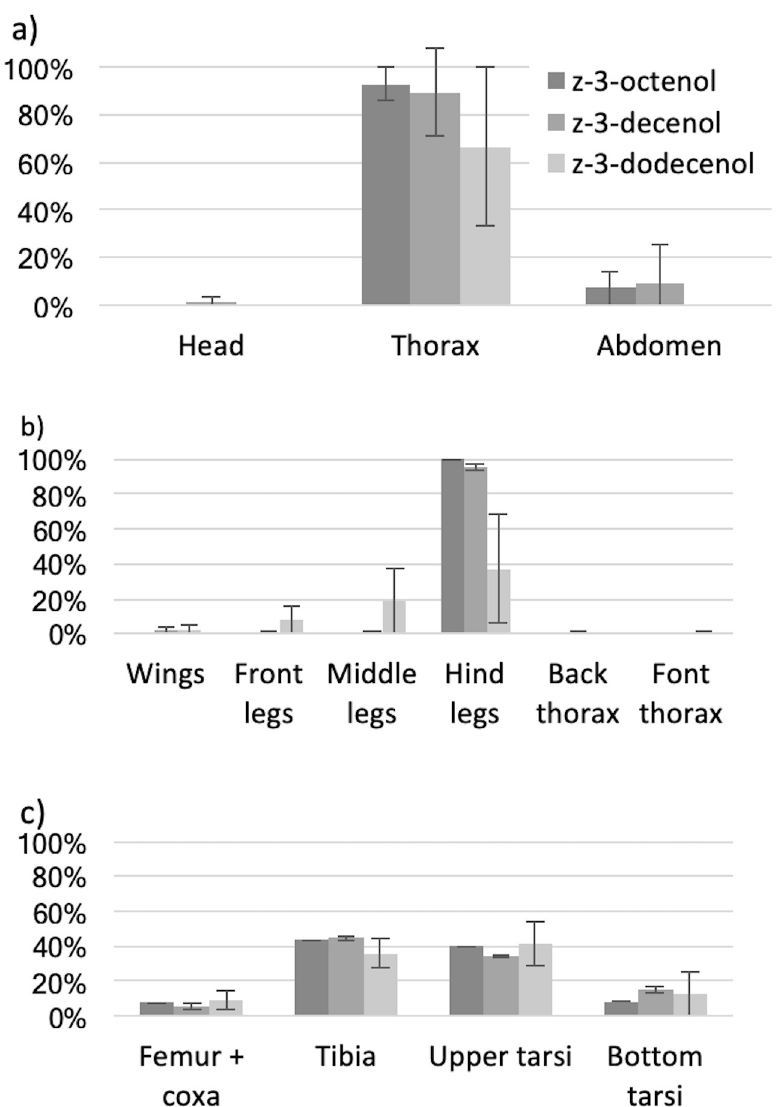
Fig 3. Confirmation of the origin of the blend of pheromone from the hind legs of males. Panel a) shows the whole body segment aerations, panel b) aerations of the portions of the thorax and appendages and panel c) the aerations of the portions of the hind legs. Percentage of pheromone released found for each series / mg of dry mass ± SD of ( Z )- 3-octenol (dark grey), ( Z )-3-decenol (medium grey) and ( Z )-3-dodecenol (light grey).